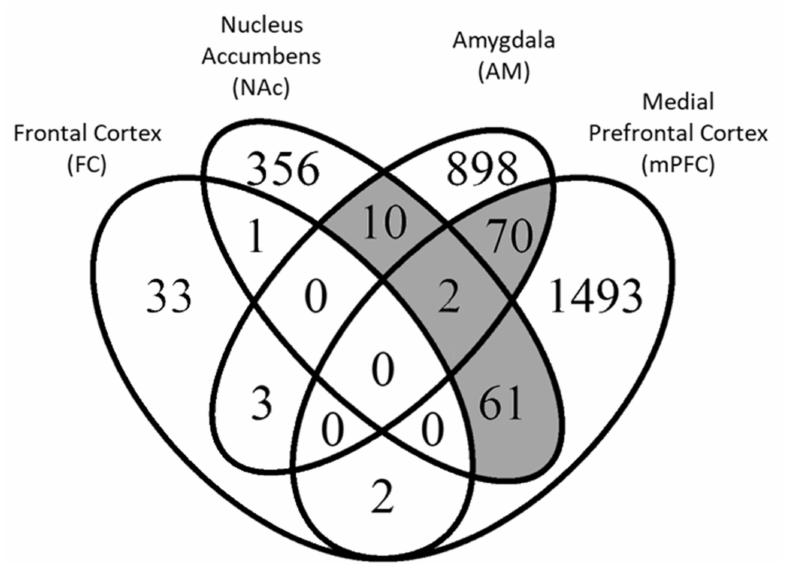
Figure 1. Differentially expressed genes (DEGs) detected at FDR < 0.1 in each respective analysis. Overlapping sets of genes with ≥ 10 genes (shaded grey) were subjected to overlap gene ontology analysis. The two genes common to Nac, AM and mPFC were Crabp1 and Drd3 .